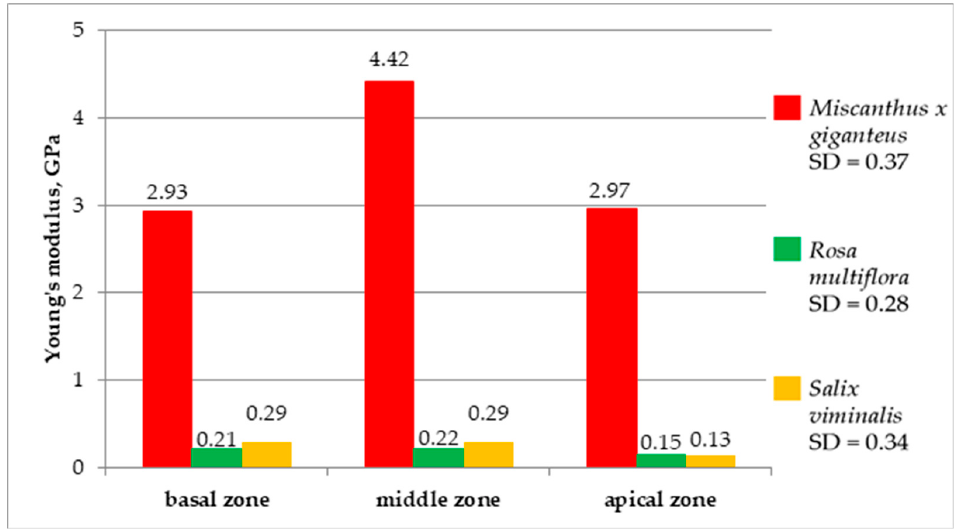
Figure 12. The average Young’s modulus of the investigated biomass.